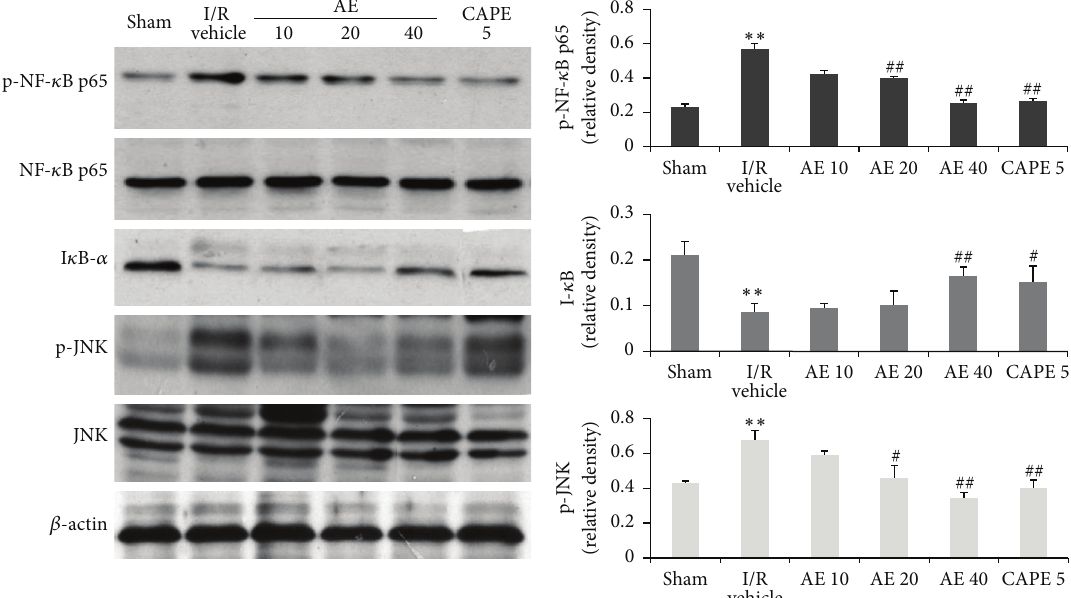
Figure 6: Effects of AE on phosphor-NF- 𝜅 B and phosphor-JNK expressions after I/R in rats. Phosphor-NF- 𝜅 b and phosphor-JNK were analyzed by western blot. Identical results were obtained in 5 separate rat hearts at each time point. Normalization of western blot was ensured by 𝛽 -actin. Different doses of CA (5, 10, or 20 mg/kg), SA extract 40 mg/kg, or saline (1mL/kg) were administered via the tail vein 1min before reperfusion. ∗∗ 𝑃 < 0.01 , versus Sham; ## 𝑃 < 0.01 , # 𝑃 < 0.05 versus I/R